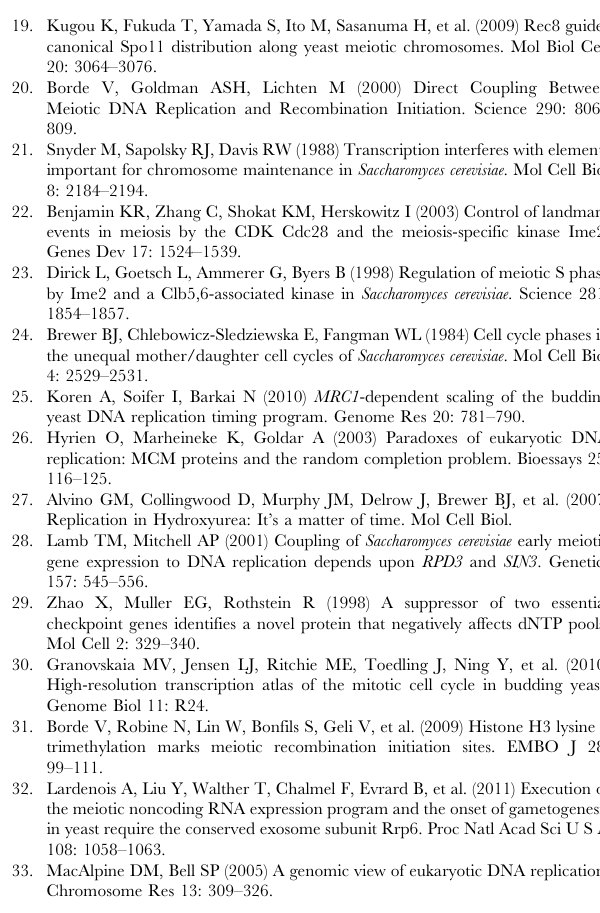
shown in red for wild-type cells without HU (H119), with HU